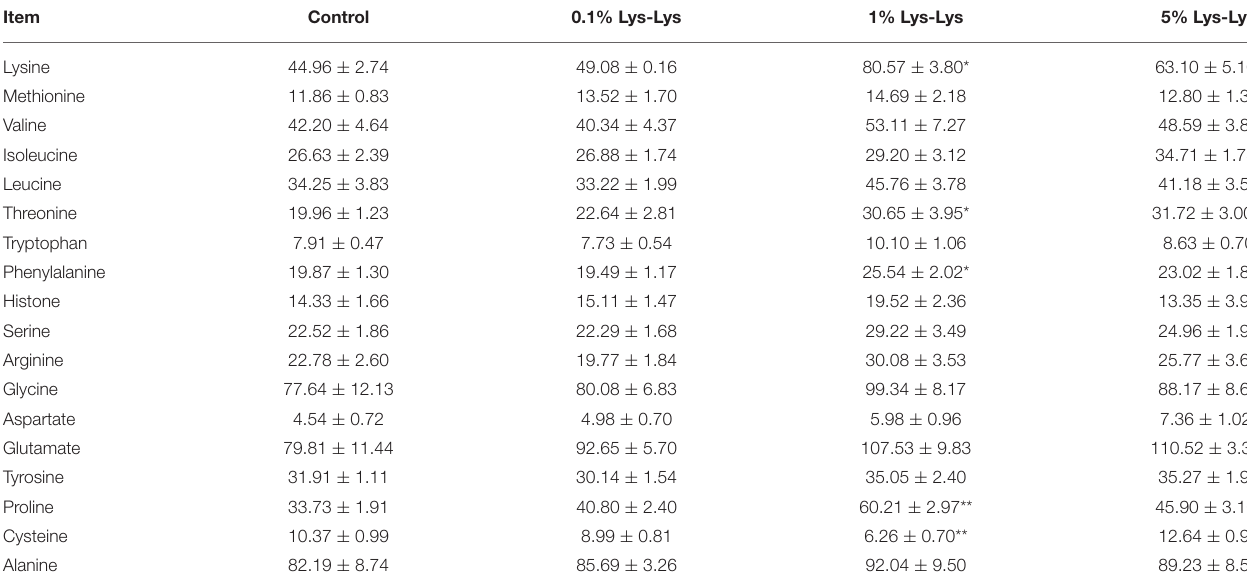
TABLE 3 | Effect of the Lys-Lys dipeptide on serum amino acids in piglets a